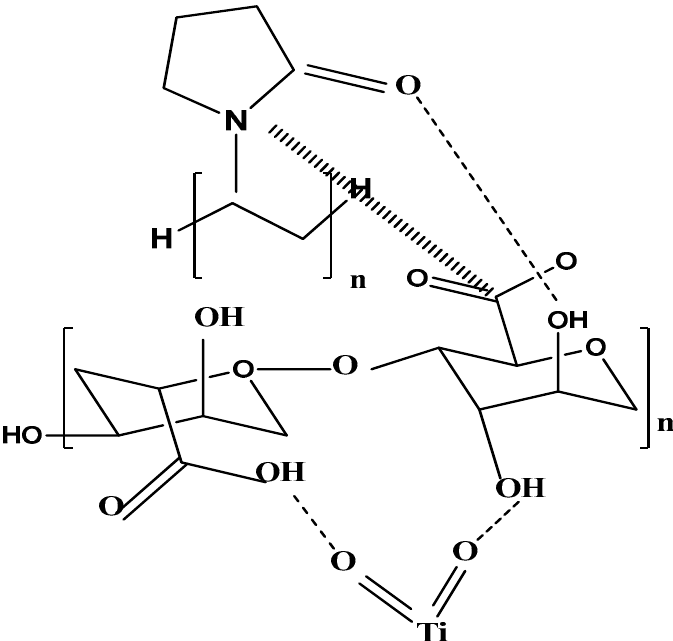
Figure 1. Possible structure of the SA/PVP/TiO 2 nanocomposite.